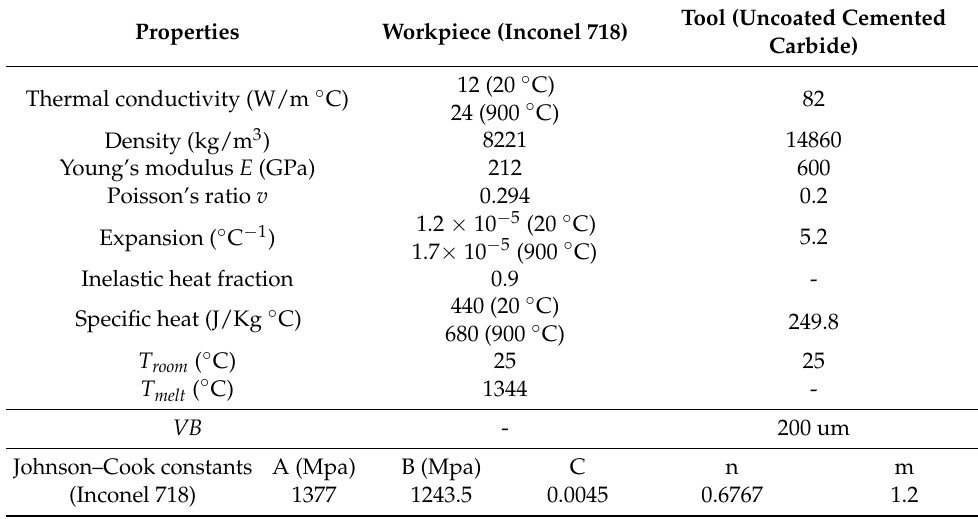
Table 2. Main properties of employed materials in orthogonal cutting tests.